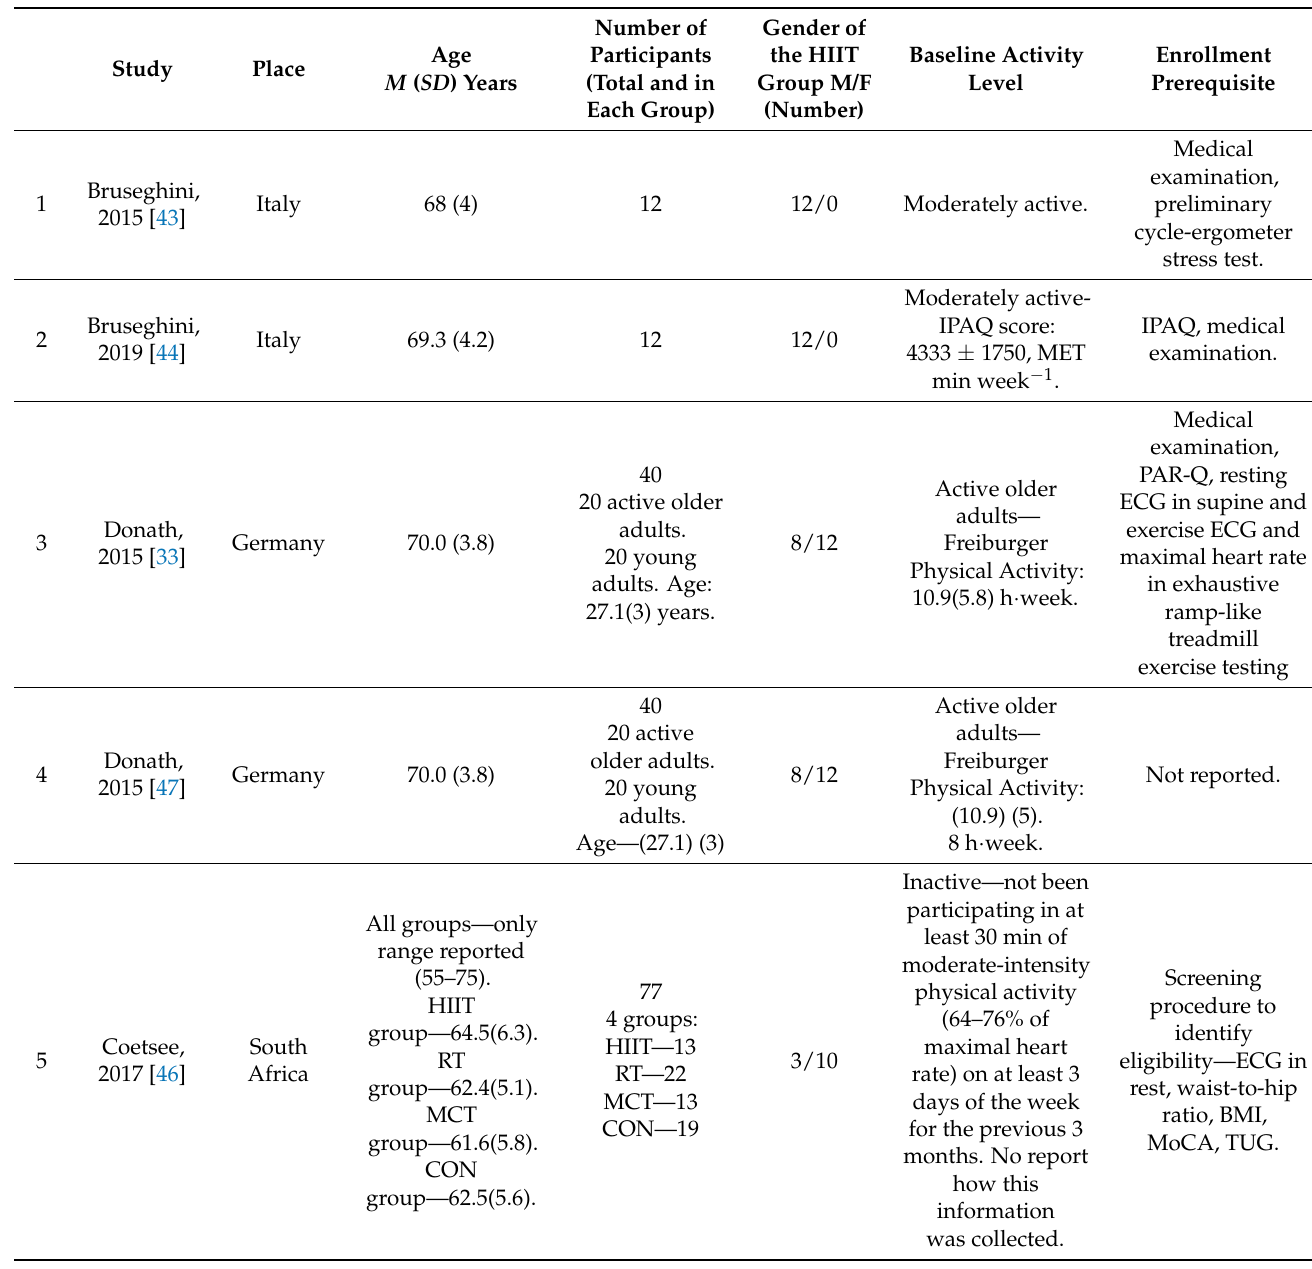
Table 1. Characteristics of the